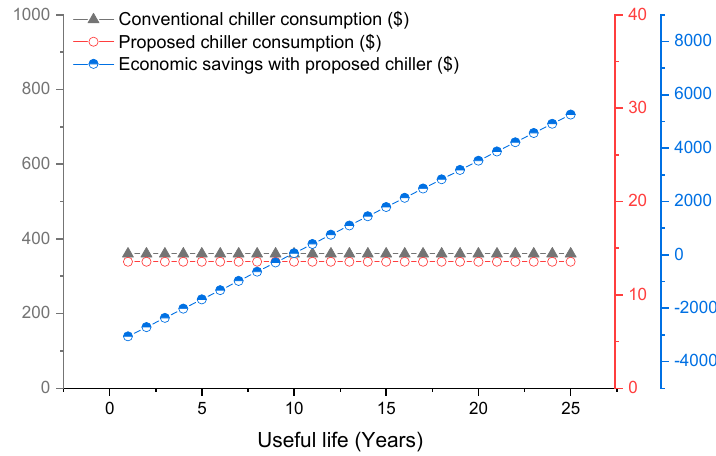
Figure 13. Economic savings caused by the proposed system.